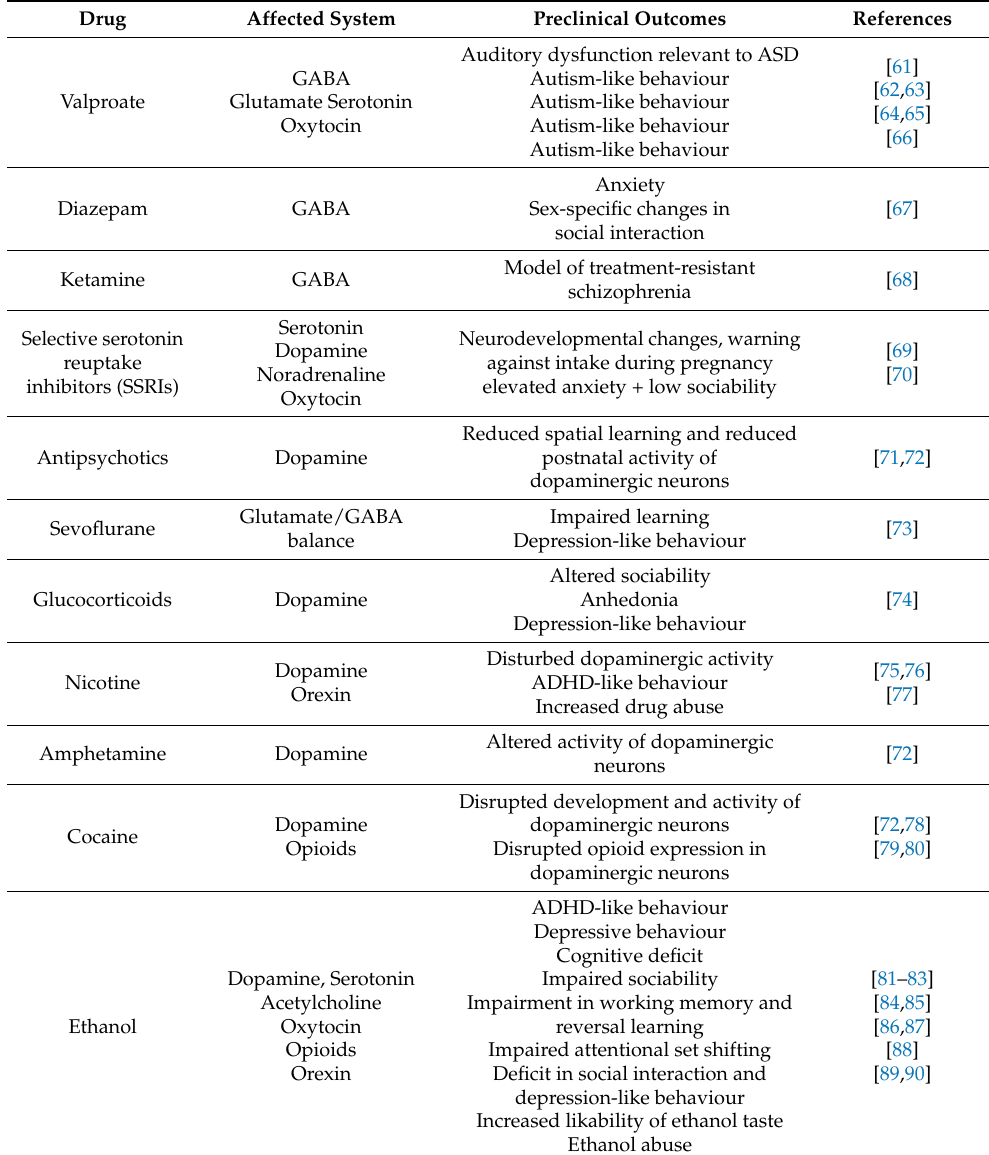
Table 1. The neuromodulatory effects of prenatal exposure to pharmacological agents and addictive substances in animal